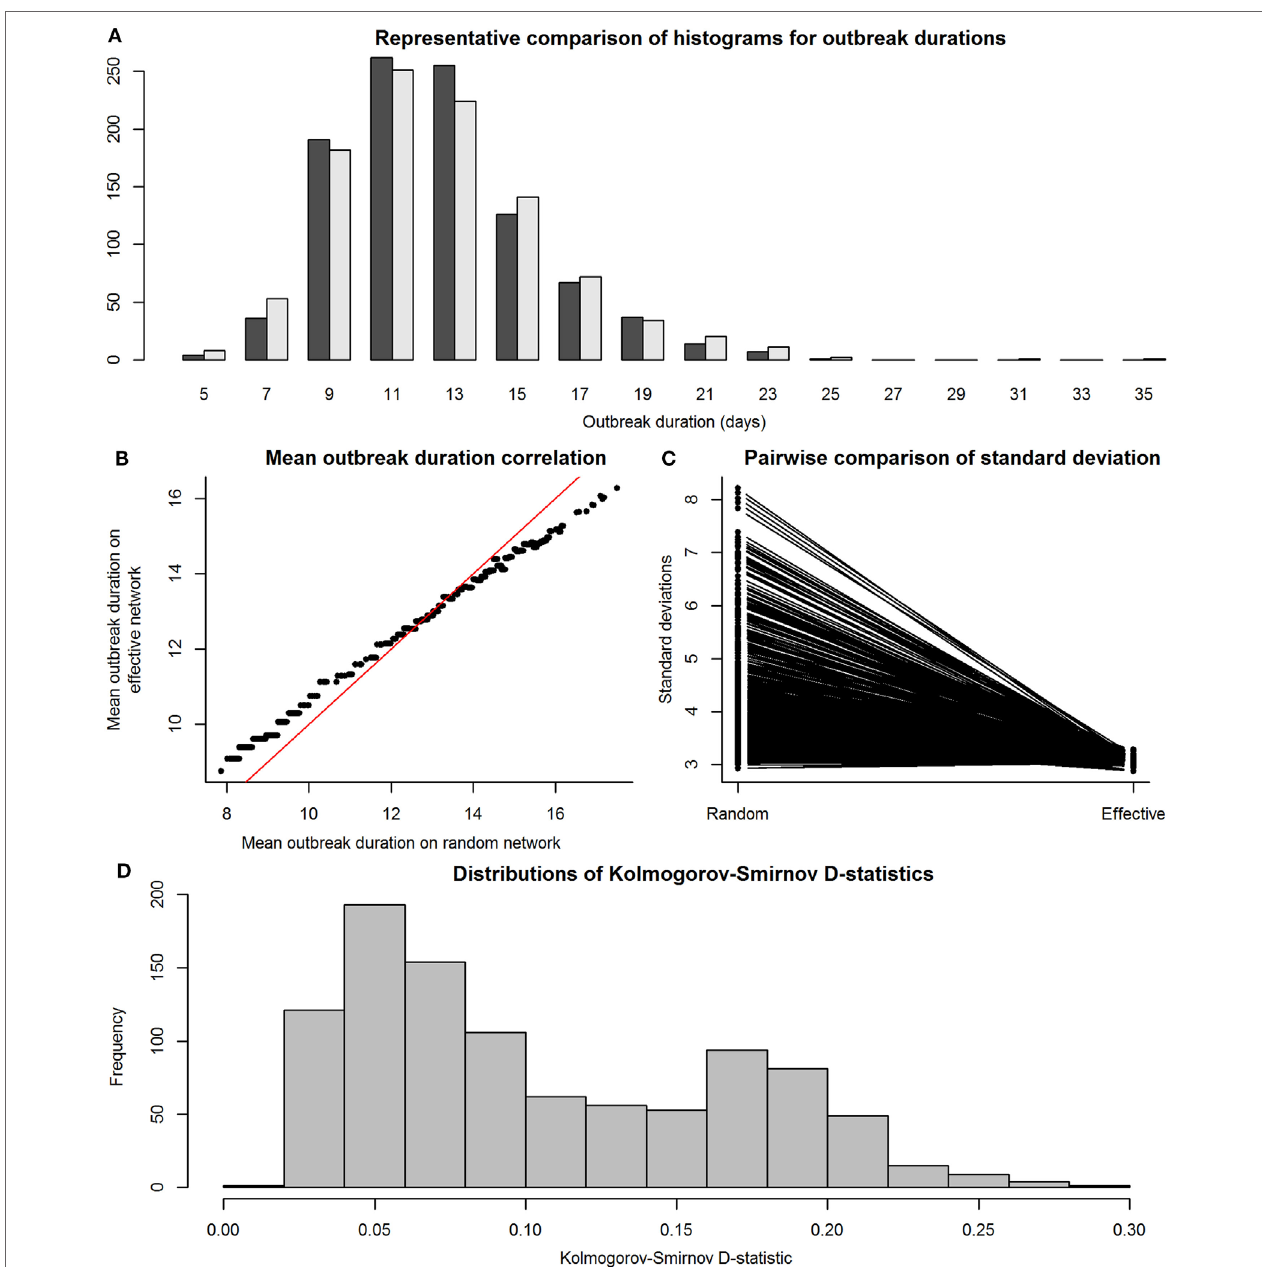
FIGURe 4 | Comparison between distributions of outbreak durations for susceptible-infected simulations on observed and effective network. Throughout the figure, the term “observed” refers to results from simulations on Erdo´´s-Rényi graphs, and “effective” refers to results from simulations on reduced major axis-predicted equivalent maximally complete networks. Network sizes are limited to a maximum of 80 individuals, as this was the condition under which we were reasonably confident in our results. Panel (A) , a histogram with a representative pair of observed (dark gray) and effective (light gray) distributions of outbreak durations plotted together for viewing overlaps, shows that the distributions, compared on a pairwise scale had a considerable amount of overlap. Panel (B) shows means of outbreak durations from observed networks plotted against those from their predicted effective networks; red line indicates 1:1 equivalence, at which effective means match observed means. Panel (C) shows a paired line plot of SDs in outbreak durations for simulations on observed and effective networks; observed networks showed higher SDs than their paired effective networks. Panel (d) shows a histogram of Kolmogorov–Smirnov D-statistics for pairwise statistical comparisons between observed and effective network outbreak durations, with values above 0.60 indicating significantly different distributions.